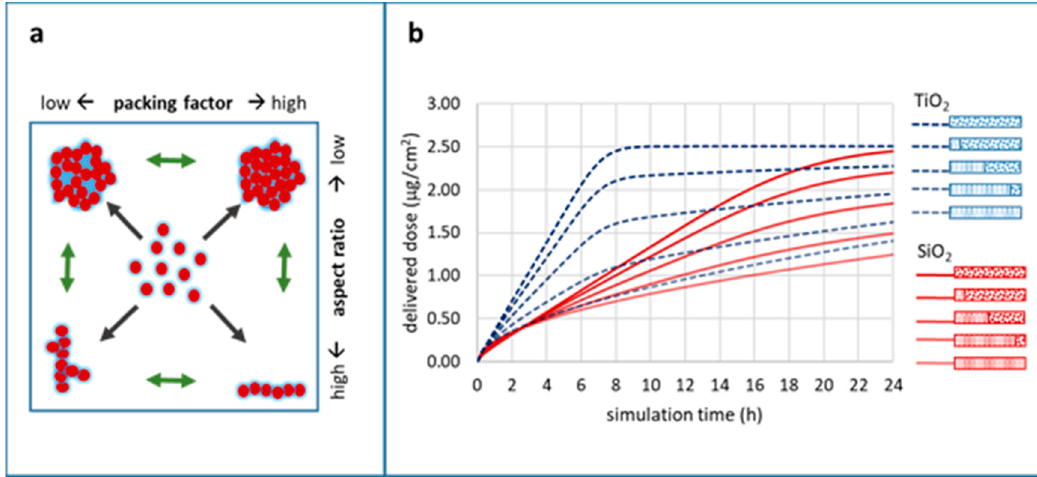
Figure 8. Agglomeration and its impact on the delivered NP dose in in vitro experiments using adherent cells. ( a ) Depending on NP characteristics and environmental conditions, primary particles may build agglomerates of different types (black arrows). This results in changes of effective density (packing factor) and shape (aspect ratio) of the newly formed agglomerates. Effective density is determined by the accumulation of intra-agglomerate fluid. Unstable agglomerates may change packing factor and shape with time (green arrows). ( b ) Different agglomeration types lead to alterations in particle mass transfer (particokinetics) and result in different delivered doses in in vitro experiments. Delivered dose prediction for two different particle types and five different mixtures of primary particles and agglomerates was performed by the ISDD in silico method simulating an in vitro submerged model. The following parameters were used for simulation (for details see Table 4): particle types: TiO 2 (blue), SiO 2 (red); primary particle diameter & shape: 50 nm, spherical;